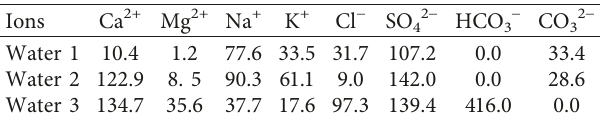
Figure 3: Typical SEM images of the crystalline samples. (a) Sample 1. (b) Sample 2. (c) Sample 3. Table 1: Ion concentrations of the water samples (mg/L). Ions